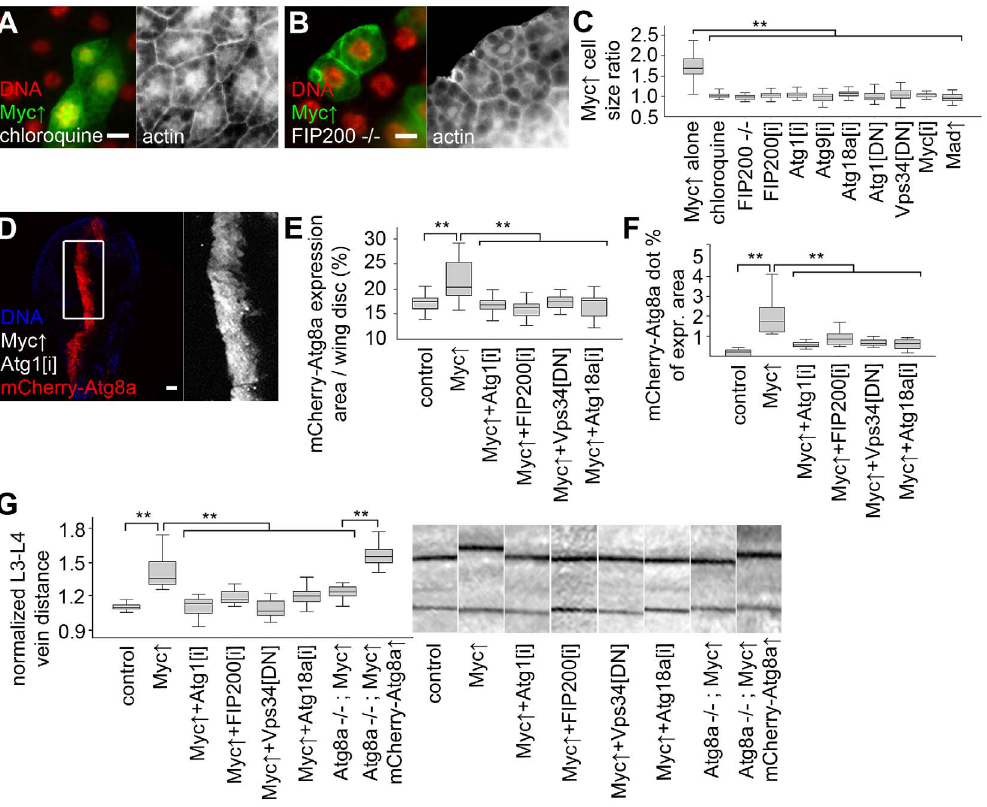
Figure 4. Autophagy is required for Myc-induced overgrowth. (A, B) Feeding larvae a chloroquine-containing diet (A) or null mutation of FIP200 (B) blocks the increased growth of Myc overexpressing cells, as the size of these GFP-positive cells is now similar to neighboring control cells. (C) Statistical evaluation shows that chloroquine treatment or blocking autophagy by null mutation of FIP200 , depletion of FIP200, Atg1, Atg9, Atg18a , and expression of dominant-negative (DN) Atg1 and Vps34 prevents overgrowth of Myc-expressing fat body cells compared to surrounding control cells to a similar extent as Myc RNAi or overexpression of Mad. n=8–11 per genotype. (D) Knockdown of Atg1 blocks Myc-induced overgrowth and punctate mCherry-Atg8a labeling in wing imaginal discs. (E, F) Quantification shows that inhibition of Atg1 , FIP200 , Vps34 or Atg18a blocks Myc- induced increases of mCherry-Atg8a expression area (E; n=10–25 per genotype) and Atg8a dot formation (F; n=10–13 per genotype) in wing discs. (G) Myc expression in the patched domain increases L3–L4 wing vein distance relative to L4–L5 vein distance, which is inhibited by knockdown of Atg1, FIP200, Atg18a , expression of dominant-negative Vps34, or null mutation of Atg8a . Expression of mCherry-Atg8a restores Myc-induced increased vein distance in Atg8a mutants. n=16–26 per genotype. Scalebars in A, B, D equal 20 m m. Statistically significant differences are indicated, ** p ,